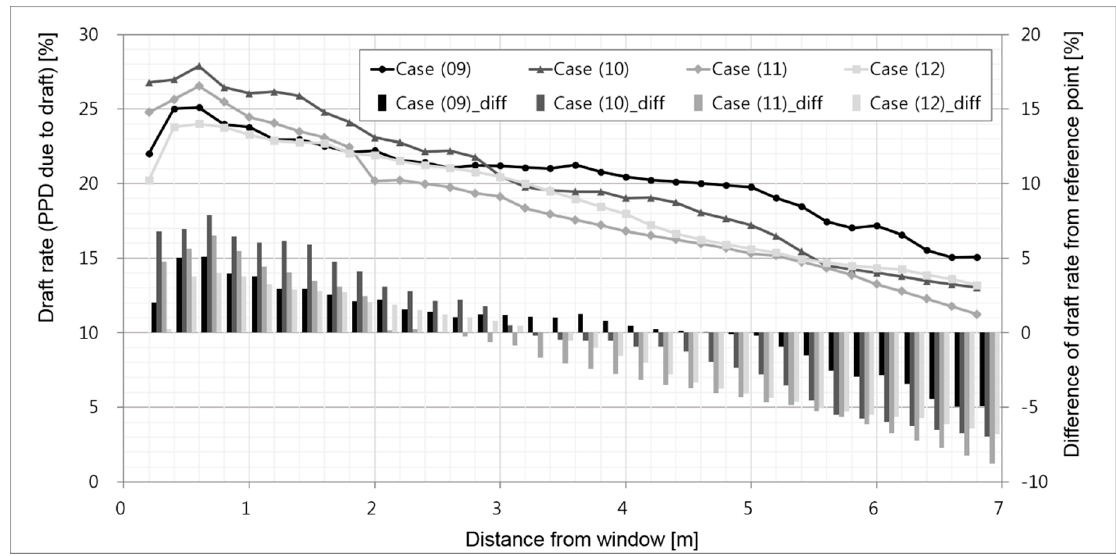
Figure 16. Draft rate by distance from window (window height is 6 m).